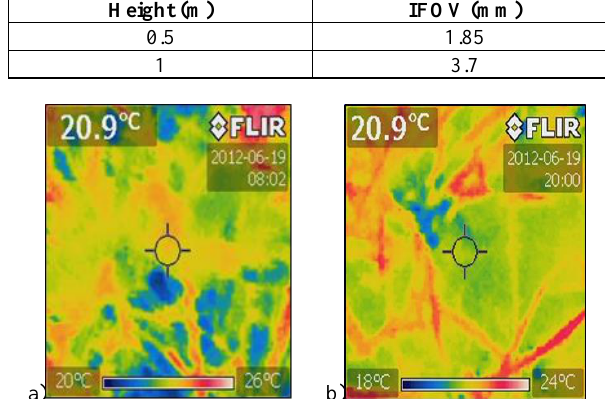
Table 3: Nominal FOV and measurement heights